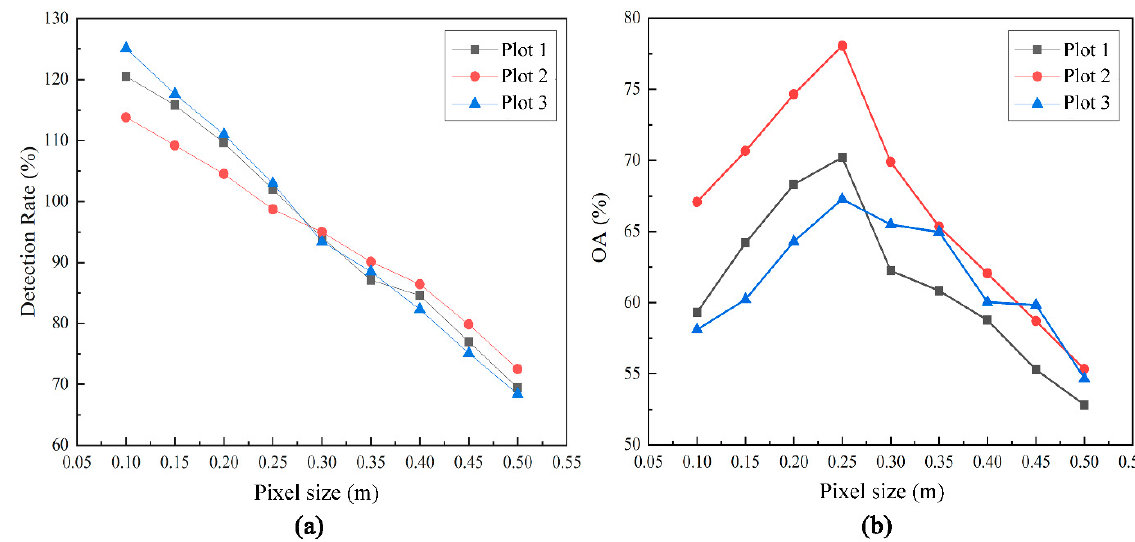
Figure 3. Comparison of individual tree crown delineation with CHM at different pixel sizes: ( a ) detection rate (%); ( b ) OA (%). We applied the RHCSA algorithm to detect individual trees in the 0.25 m CHM and detected 2.9 million individual trees in the study area. We used the three 100 m × 100 m sample plots (2688 trees in total) to assess the accuracy of individual tree crown delineation. Figure 4 illustrates the individual treetops detected using the RHCSA algorithm (blue lines) with green points representing reference treetops.